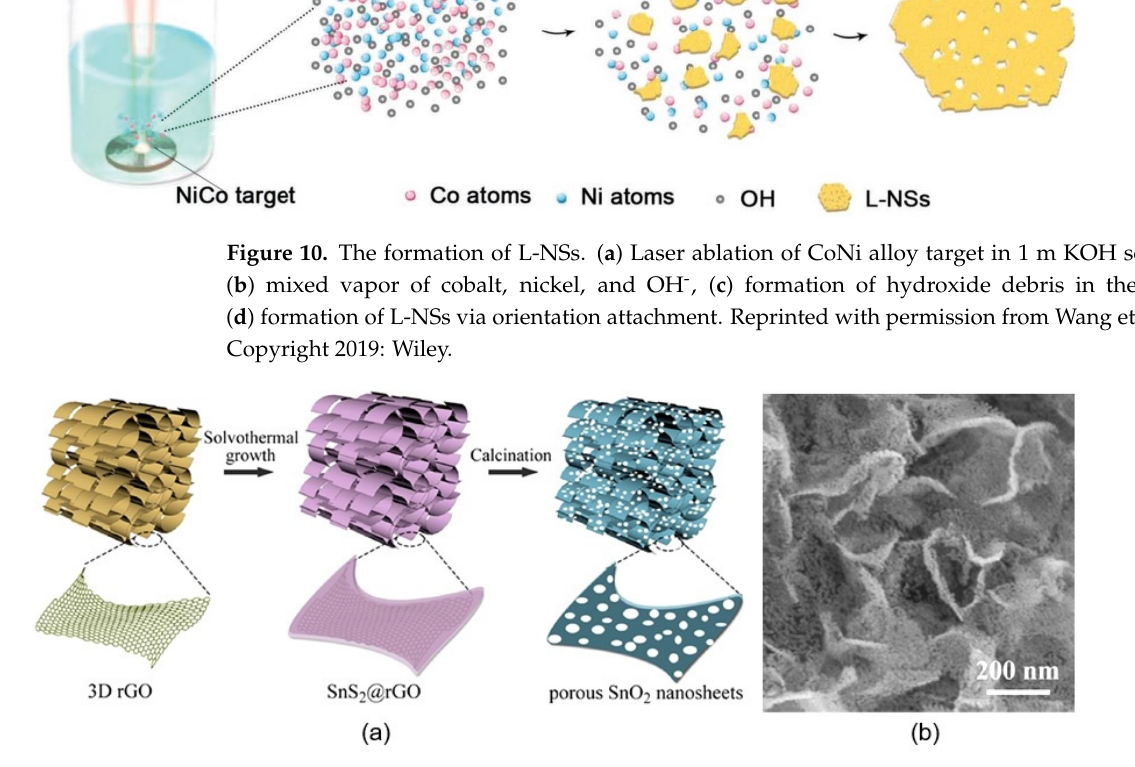
Figure 11. ( a ) Schematic diagram of the synthesis procedure and (b ) SEM image of porous SnO 2